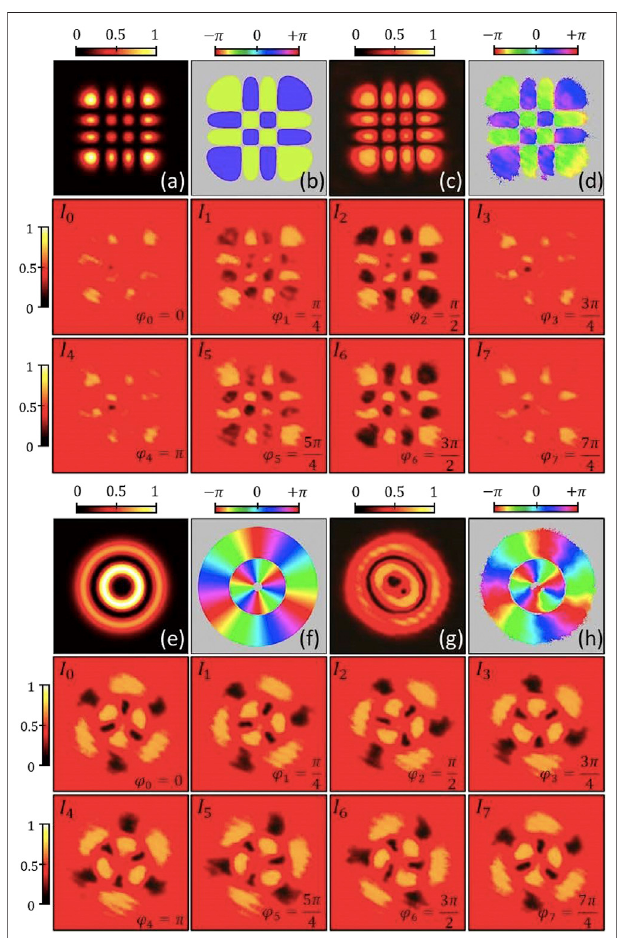
FIGURE 3 | Realization of a HG 33 (A – D) and LG 13 (E – H) beam. Theoretical intensity (A,E) and phase (B,F) distributions. Experimental intensity (C,G) and phase (D,H) distributions. The phase distribution of each beam is retrieved from the interferograms shown below each case with eight consecutive phase shifts of step Δ φ (cid:1) π